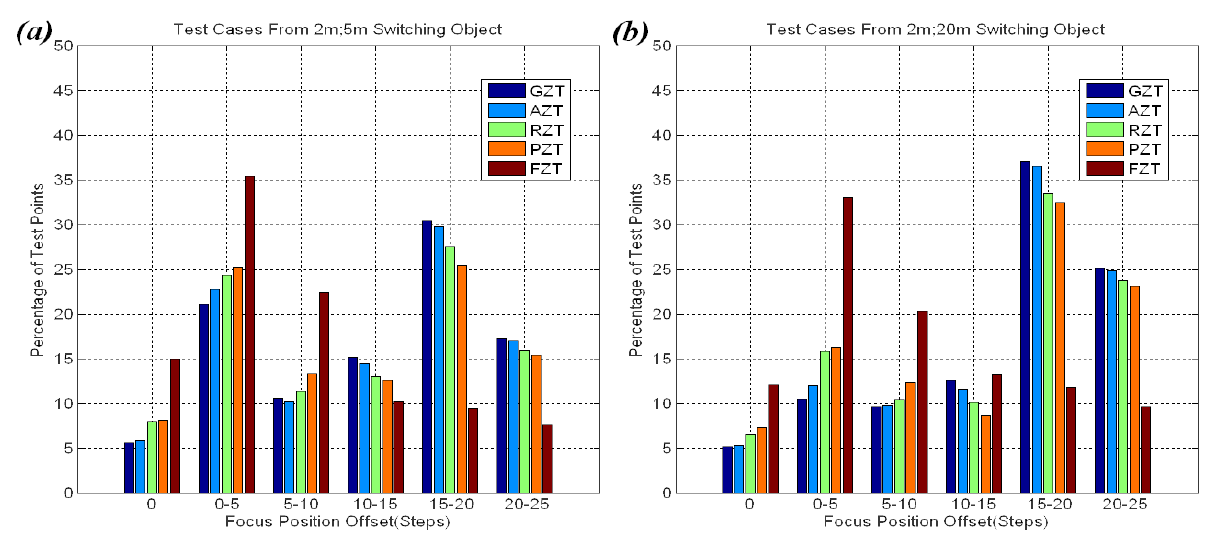
Figure 18. ( a ) Offset distribution for objects switching from 2 m to 5 m; ( b ) Offset distribution for objects switching from 2 m to 20